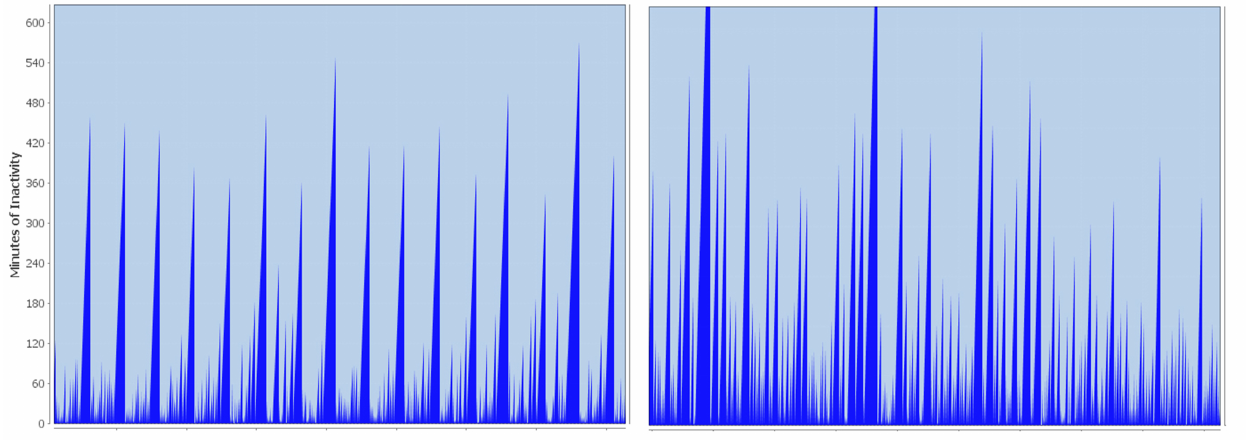
Figure 10. Inactivity patterns of two